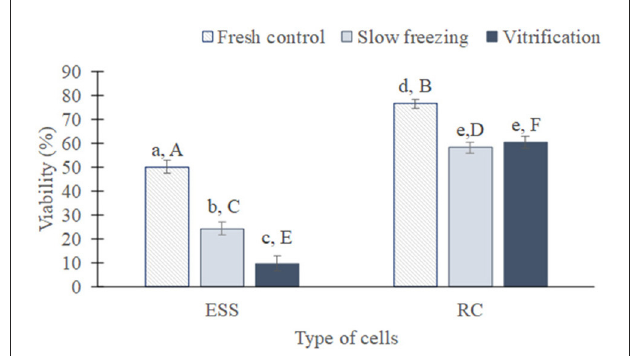
FIGURE4 Global viability of testicular cells (mean from all species ± SEM) from fresh, slow frozen-thawed and vitrified-warmed samples. Different lowercase letters represent differences ( P < 0.05) between treatments for each cell type. Different capital letters represent differences ( P < 0.05) between cell types in each treatment. ESS, elongated spermatids and spermatozoa; RC, rounded cells (spermatogonia, spermatocytes, early spermatids).